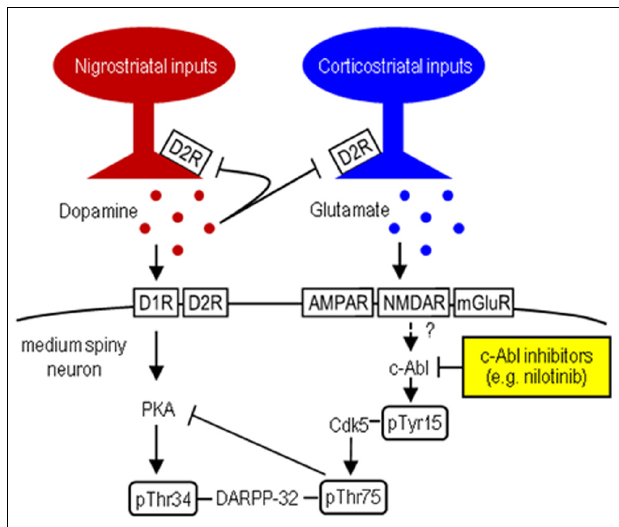
FIGURE 1 | Striatal Cdk5/DARPP-32 signal regulation. Hypothesized model shows striatal dopamine and glutamate neurotransmissions involving postsynaptic dopamine/PKA/DARPP-32-pThr34 and glutamate/Cdk5/DARPP-32-pThr75 signaling cascades. c-Abl inhibitors (e.g., nilotinib) target c-Abl that can activate Cdk5 by phosphorylating it